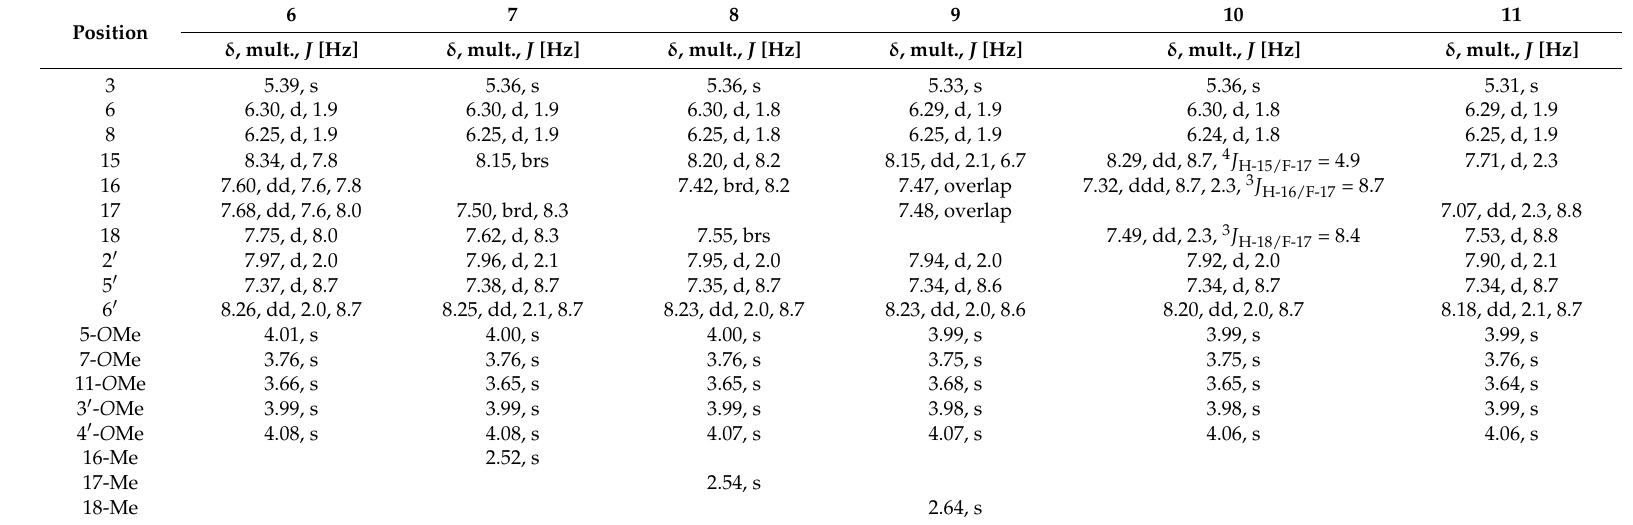
Table 1. 1 H-NMR data of nudicaulin derivatives 6 to 11 (500 MHz, MeOH- d 4 /1%